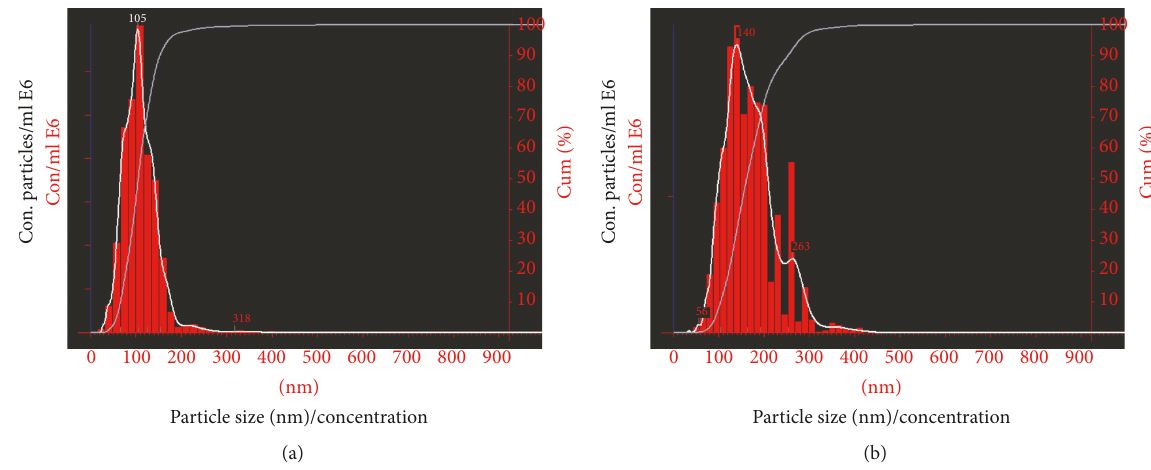
Figure 4: Concentration and size distribution from NTA measurements of c omplexes Co 8 (BH20) (a) and Co 10 (BH20) (b) in aqueous solution.